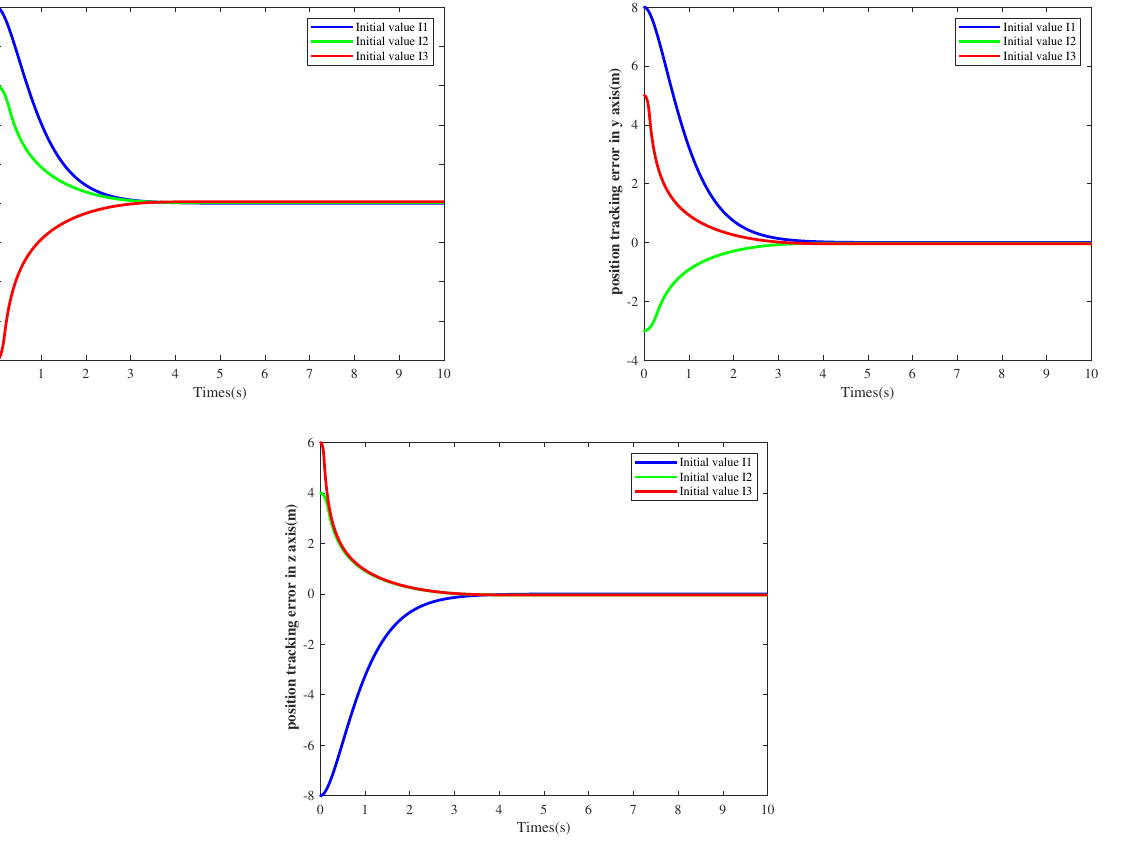
Figure 16. Position tracking error of different initial